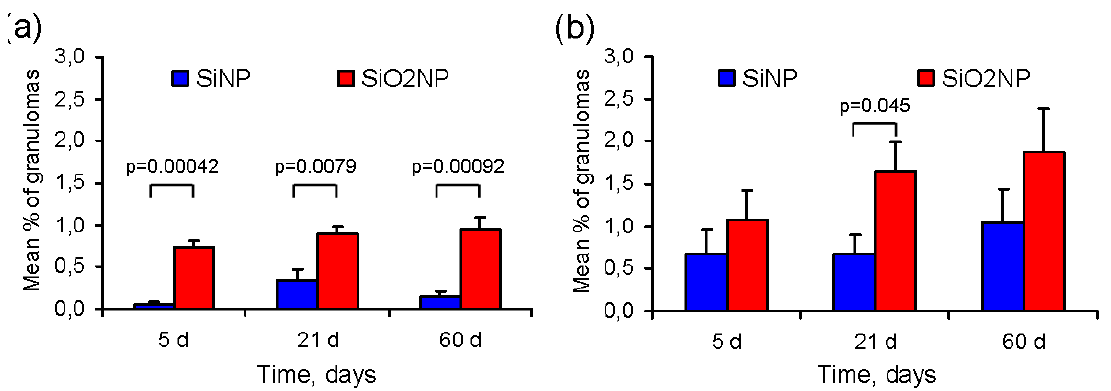
Figure 7. The mean percentage of granulomas in the ( a ) liver; and ( b ) spleen at 5, 21, and 60 days after intravenous infusion of silicon and silica nanoparticles (SiNPs and SiO respectively). The results are shown as the mean percentage of granuloma area ± SD of six different sections from three different rats (two sections per